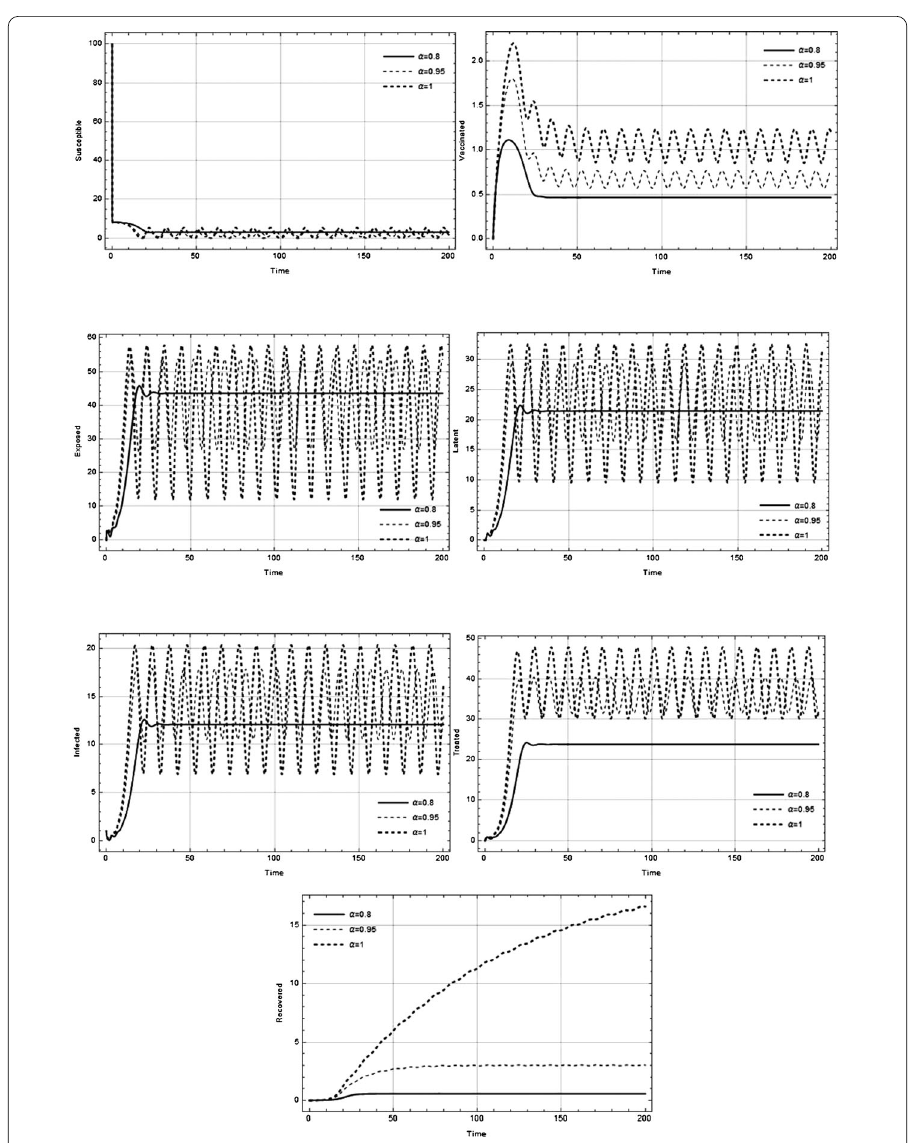
Figure 4 Endemic equilibrium state of SVELITR at different values of α for R 0 > 1 and τ = 0.9 > τ